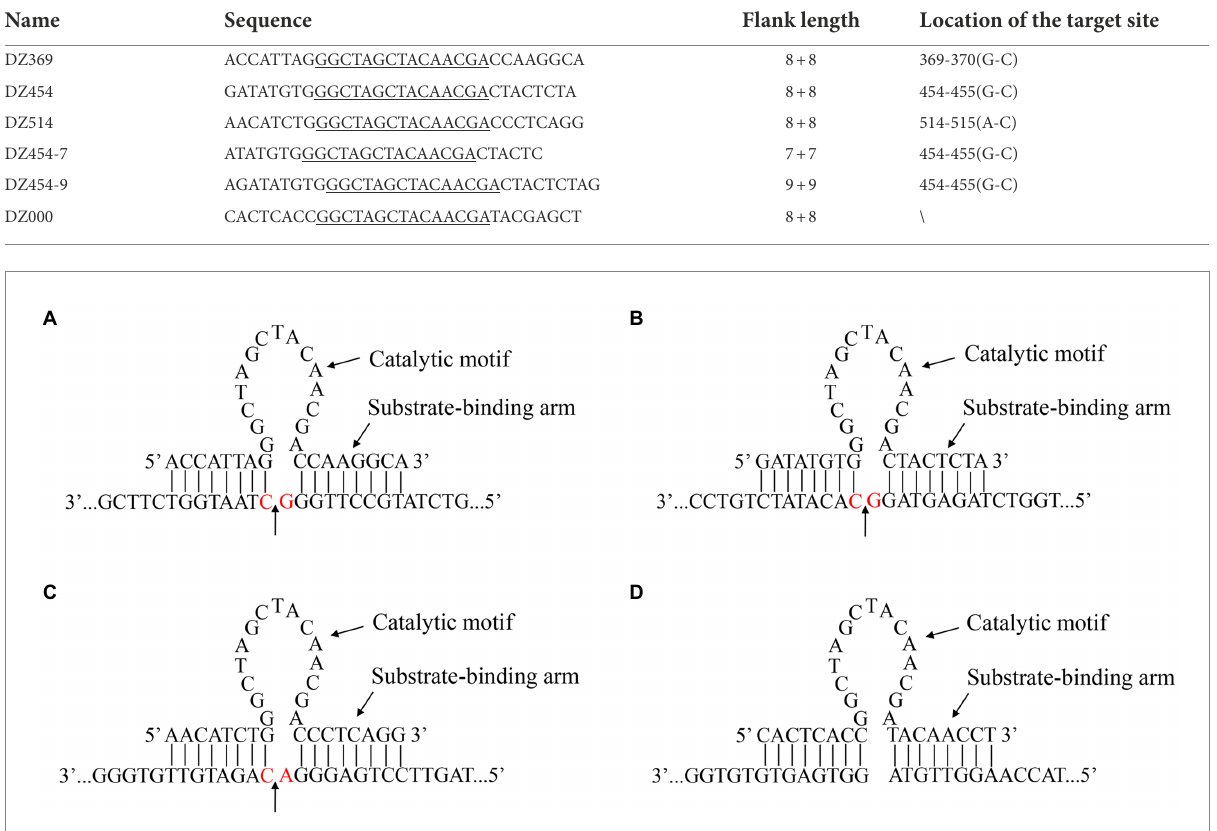
FIGURE 1 Gene sequence and secondary structure of the DNAzymes. The recognition and catalytic sequences of DZ369 (A) , DZ454 (B) , DZ514 (C) , and DZ000 (D) , and their corresponding cleavage sites. The red base shows the location of a target